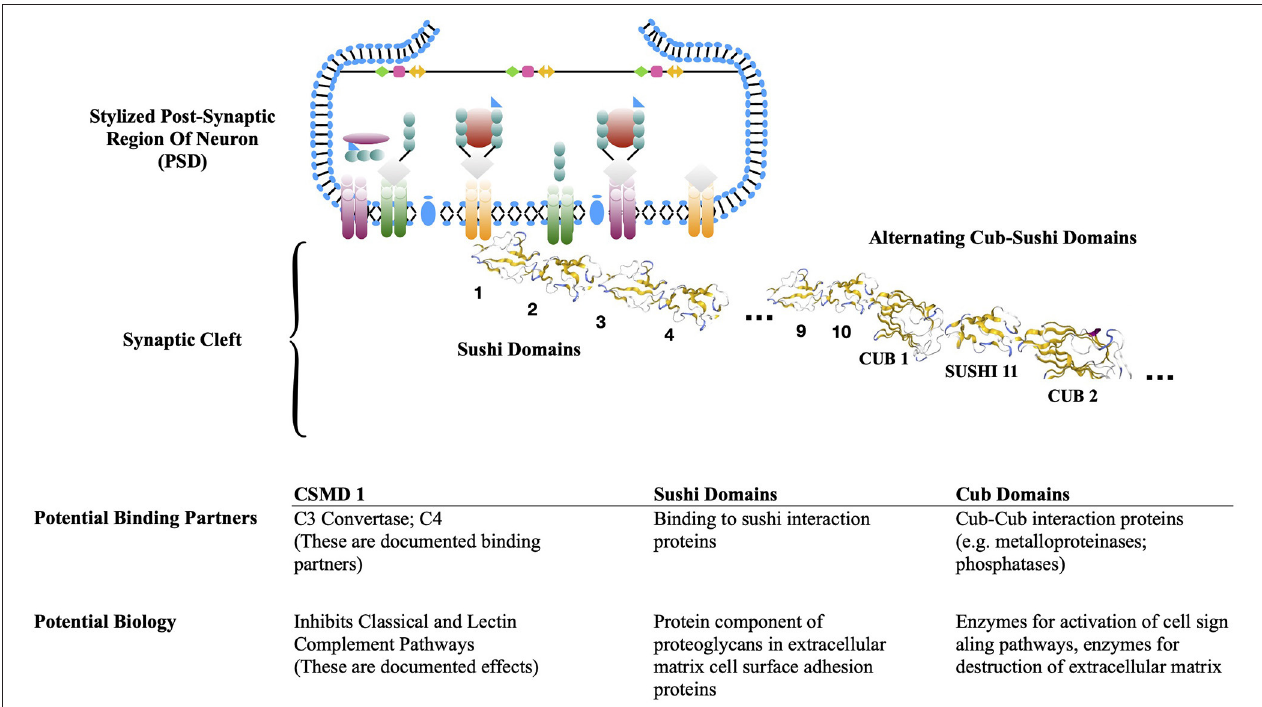
FIGURE 8 | Post-synaptic density with CSMD. Model of CSMD protein at the protein-rich PSD. CSMD proteins are membrane bound proteins with a transmembrane domain and an extensive extracellular domain with a defined structure of 10–14 consecutive Sushi domains, then alternating CUB-Sushi domains. A stylized PSD and a CSMD protein with representative CUB and Sushi crystal structure are shown. The table below describes anticipated binding partners based on the families of proteins with CUB domains and/or Sushi